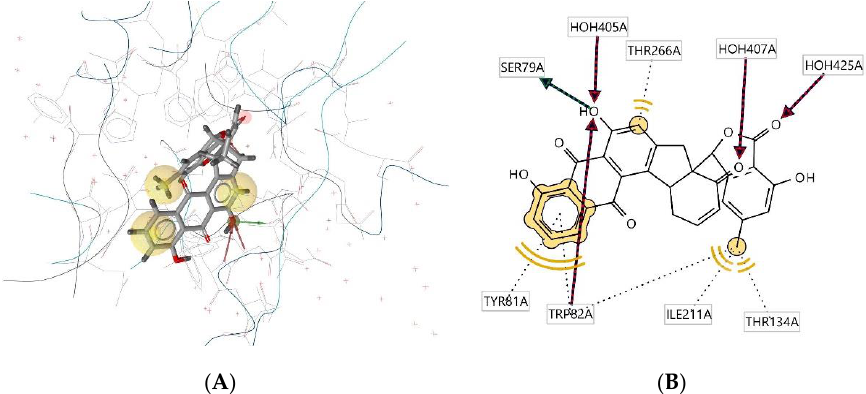
Figure 9. Ligand 310D interacts with the macromolecule. ( A ) 3D view of pharmacophore at the macromolecule binding site. ( B ) 2D view of pharmacophore. Pharmacophore features: hydrophobic interactions (H), yellow; hydrogen bond acceptor (HBA), red; hydrogen bond donor (HBD), green.